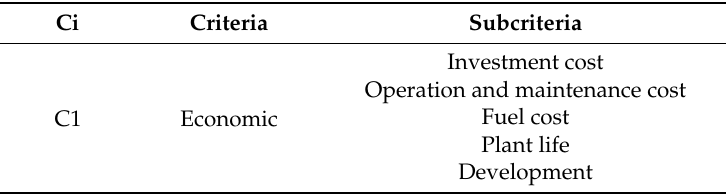
Table 1. Criteria for the pairwise (PW)